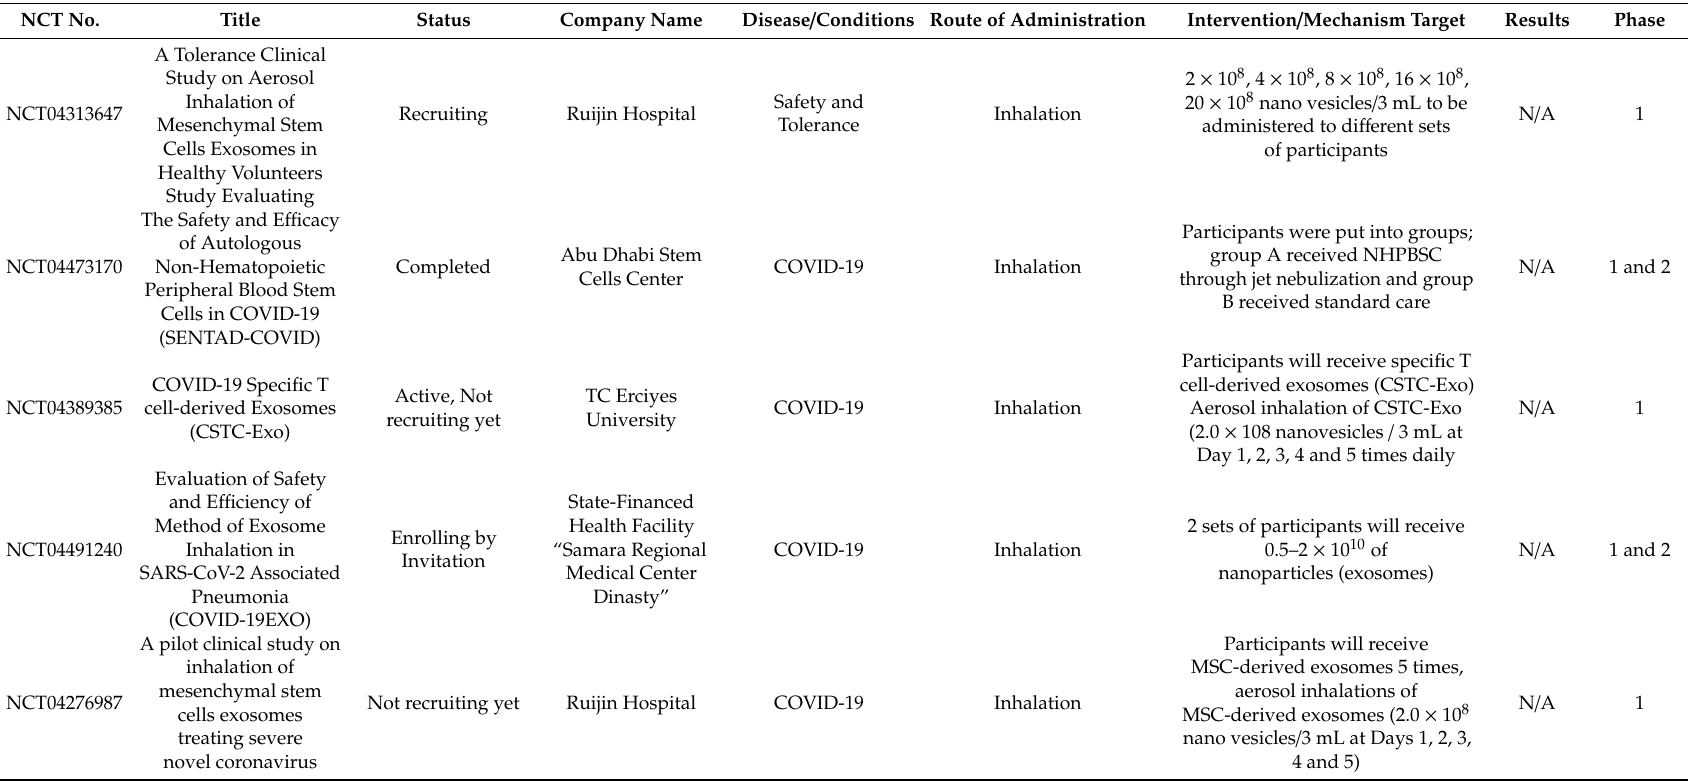
Table 4. Aerosol and aerosolized cell therapy clinical